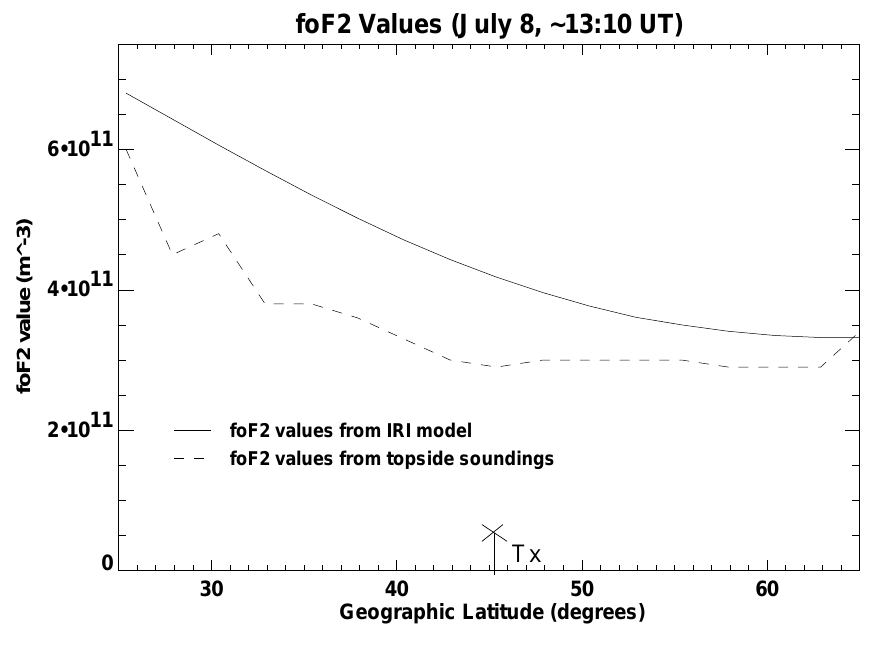
Fig. 4. The fo F2 values obtained from both the IRI model and the ISIS II topside soundings for the pass on 8 July 1978, 13:10